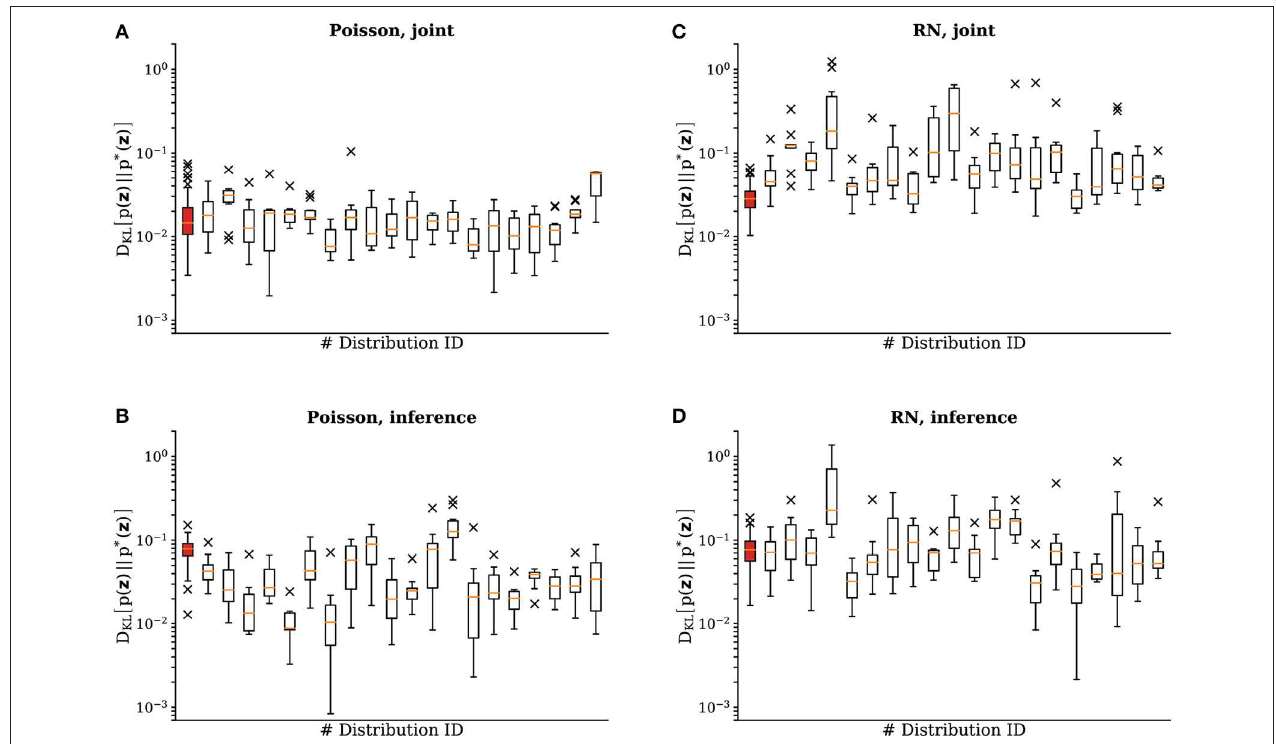
FIGURE 5 | Emulated SSNs sampling from different target Boltzmann distributions. This figure shows the results of experiments identical to the ones in section 3.1 for 20 different target distributions with 10 repetitions for each sample. We show the D KL ( p k p ∗ ) of the test-run after training for (A) the joint distributions with Poisson noise, (B) the inference experiment with Poisson noise, (C) the joint distributions with a random background network and (D) the inference experiment with a random background network. The data is plotted following the traditional box-and-whiskers scheme: the orange line represents the median, the box represents the interquartile range, the whiskers represent the full data range and the × represent the far outliers. In each subplot the leftmost data (highlighted in red) corresponds to the distribution shown in Figure 4